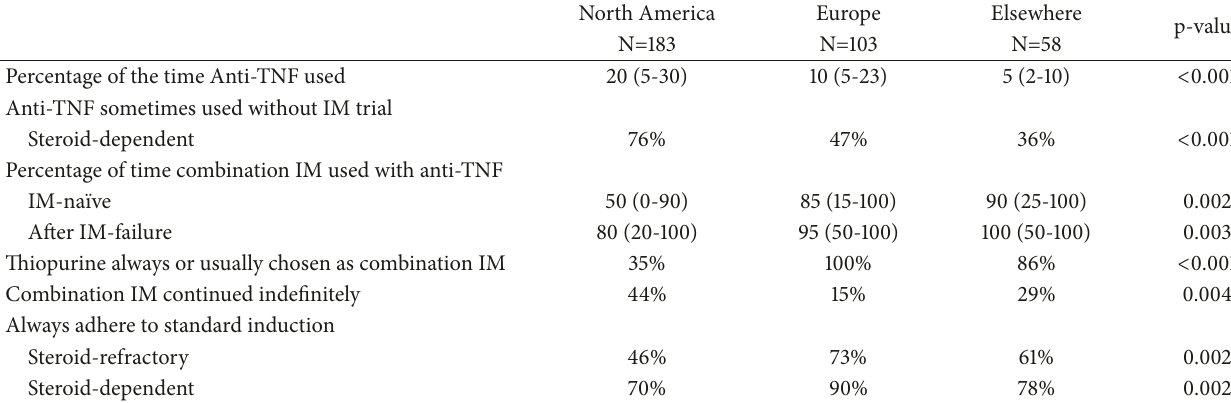
Table 3: Practice patterns in ulcerative colitis with infliximab. Results are presented as percentages or median (interquartile range) as appro-